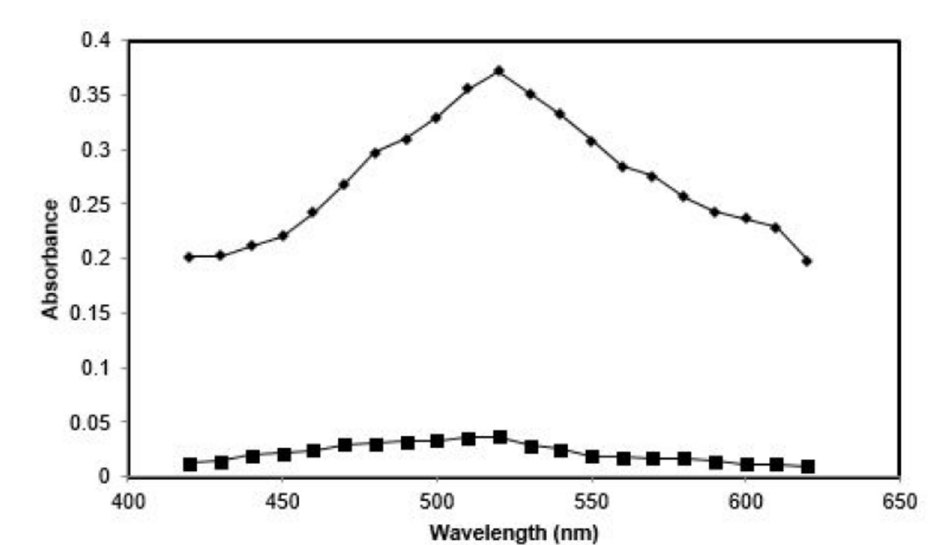
FIGURE 5 - Absorption spectra of 2, 6- dichloroquinone chloride [DCQC] and reagent blank. Absorption spectrum oxidative coupling product of PPE-DCQC ([PPE]= [1.13×10 -4 M] and [DCQC]= [9.52×10 -4 M]. Absorption spectrum of reagent blank vs